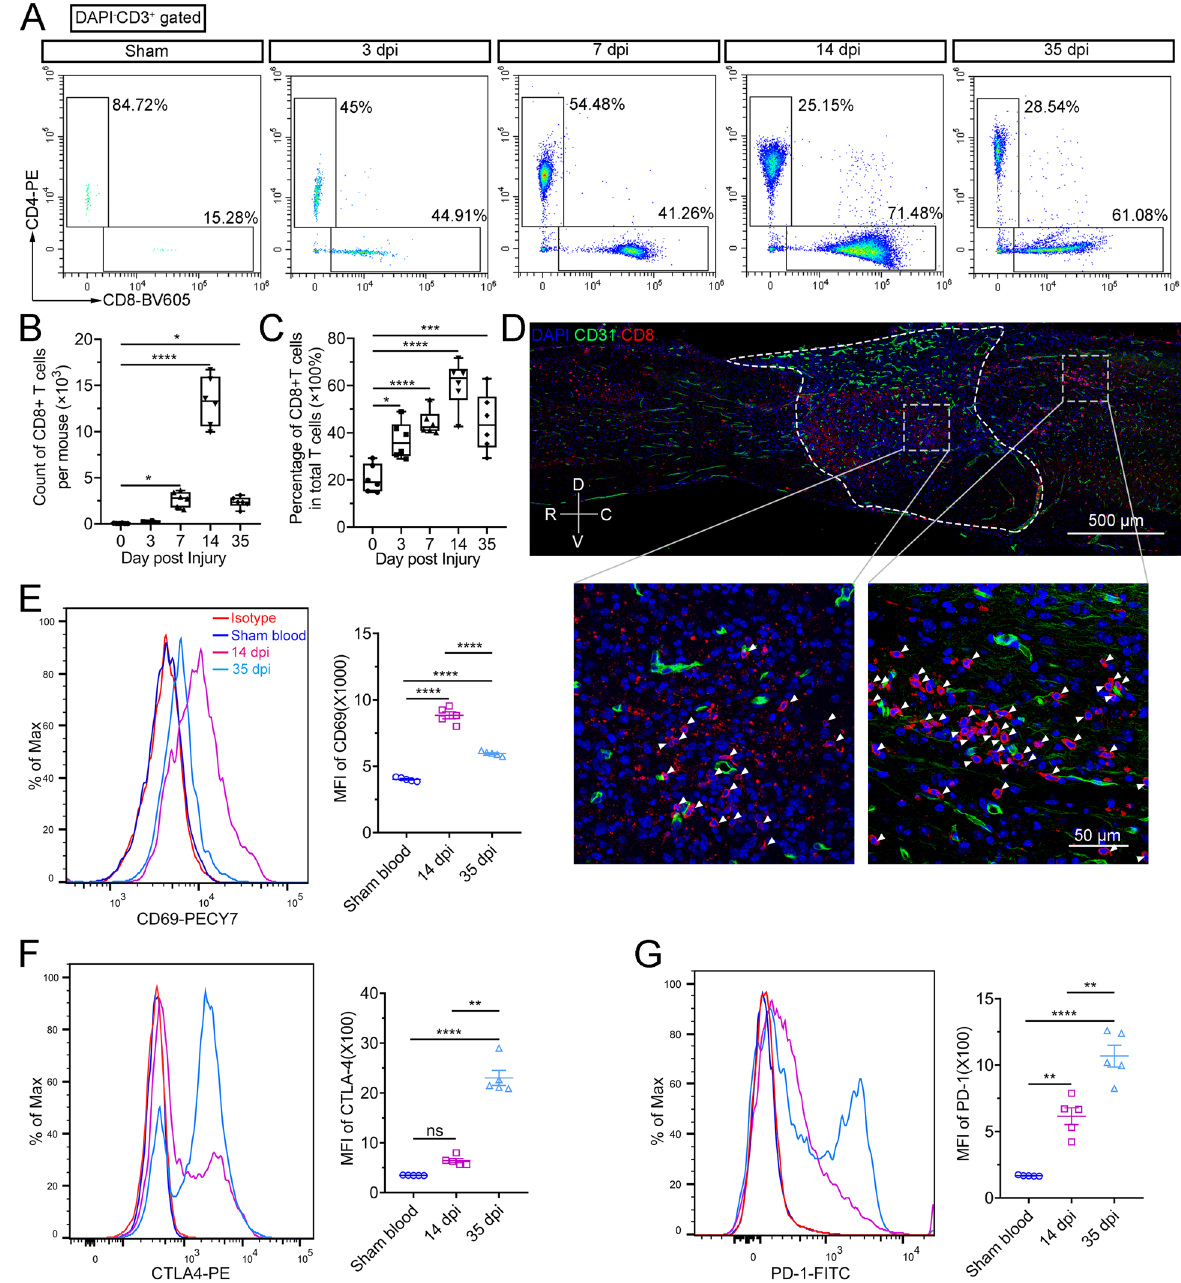
Fig. 1 Infiltration of activated CD8 + T cells increased in the injured spinal cords. A Representative flow cytometry images showing the percentage of CD8 + T cells (CD3 + CD4 − CD8 + ) at 0, 3, 7, 14, and 35 dpi after SCI, n 6 independent mice. B and C Statistical box plots of A , * P < 0.05, *** P < = 0.001, **** P < 0.0001, one‑way ANOVA with Tukey. D Immunofluorescence images of a sagittal section showing the location of CD8 + T cells (red) after SCI at 14 dpi. CD31 (green) is used to label endothelial cells of blood vessels. The lesion border was outlined by a dashed white line. V, ventral; D, dorsal; R, rostral; C, caudal. Scale bar, 500 μm or 50 μm. E – G Flow cytometry images showing the expression levels of CD69, CTLA‑4, and PD‑1 in CD8 + T cells in sham blood, 14 dpi, and 35 dpi groups, respectively. n 5 independent mice. ** P < 0.01, **** P < 0.0001, one‑way ANOVA with Tukey. = MFI, mean fluorescence